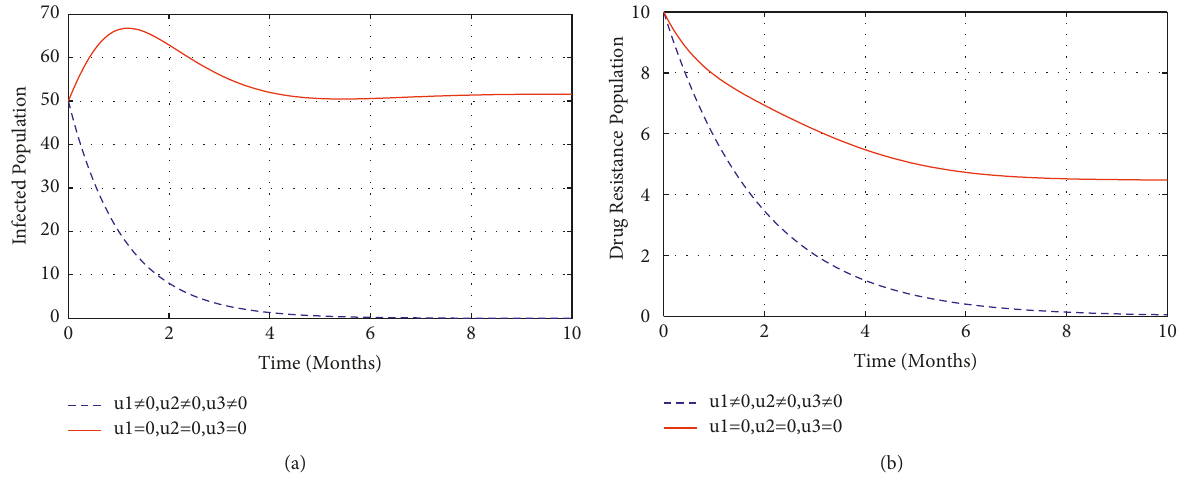
Figure 8: Impact of education and treatment of infectious and drug resistance on infectious and drug resistance populations.